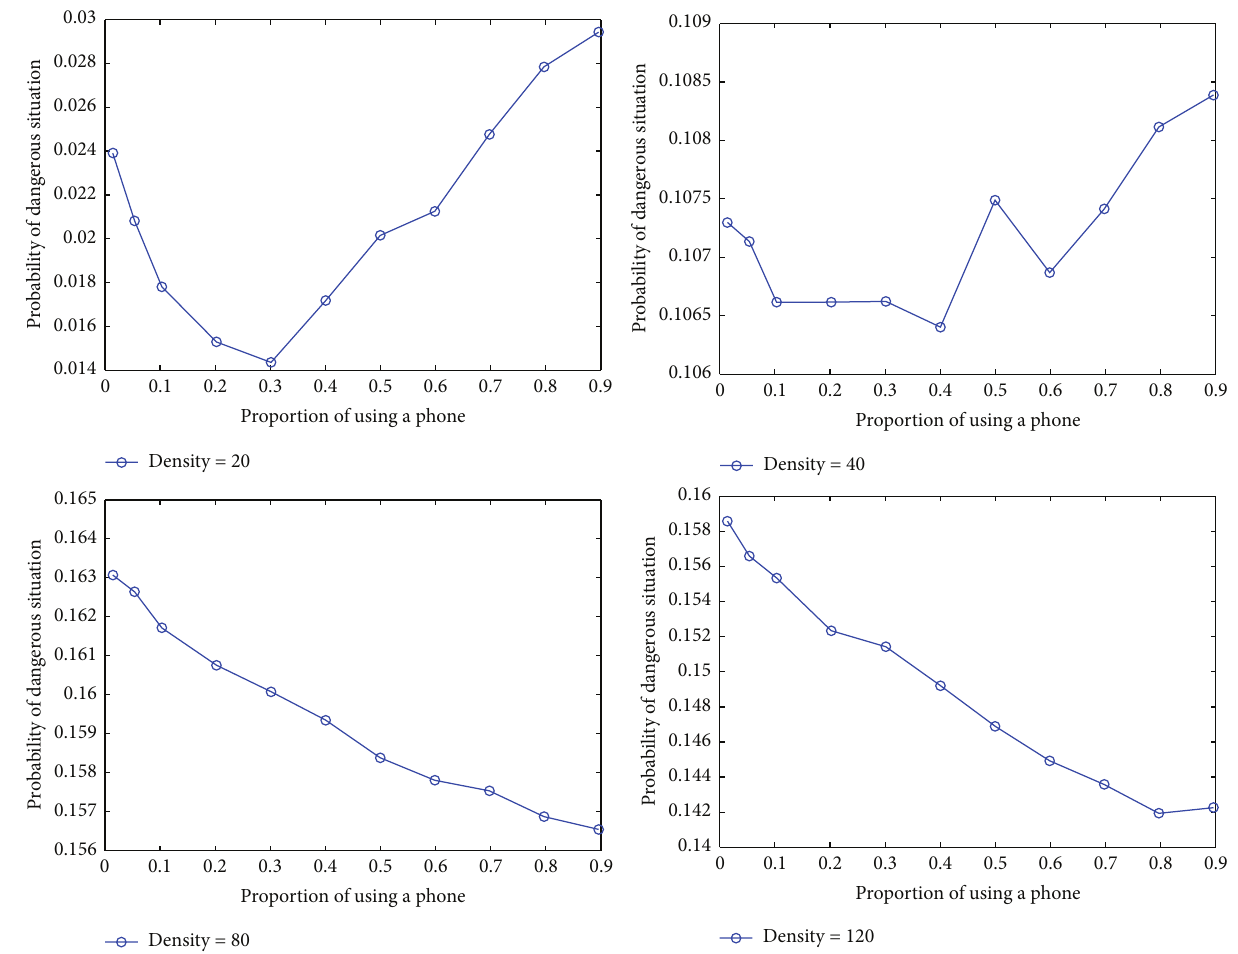
Figure 11: The relationship between traffic risk and phone